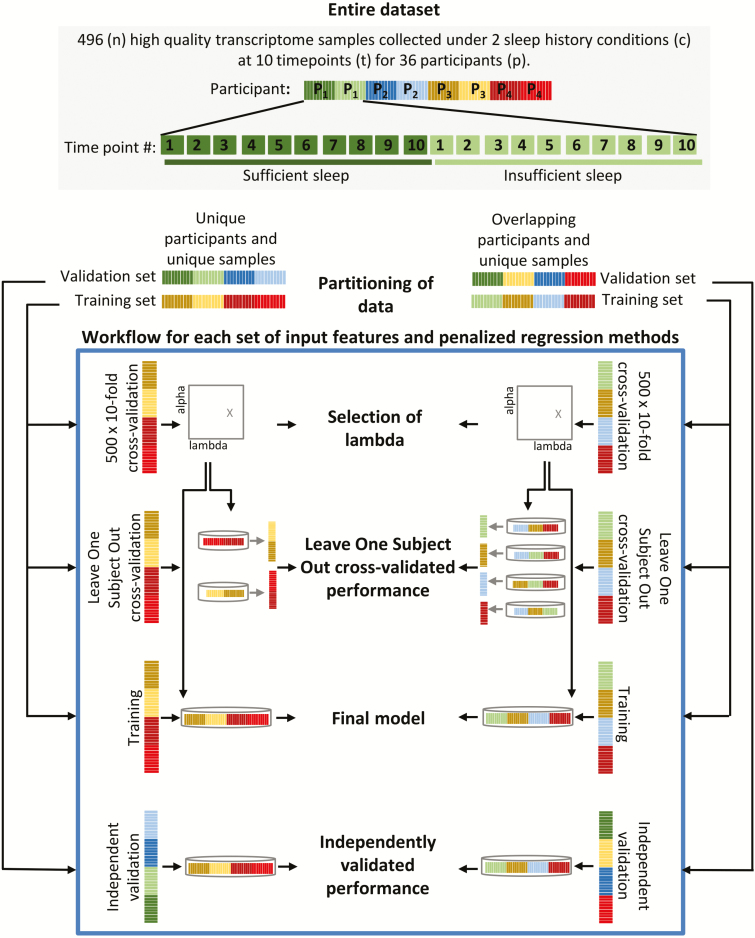
Overview of our approach to identifying panels of biomarkers and assessing their performance.